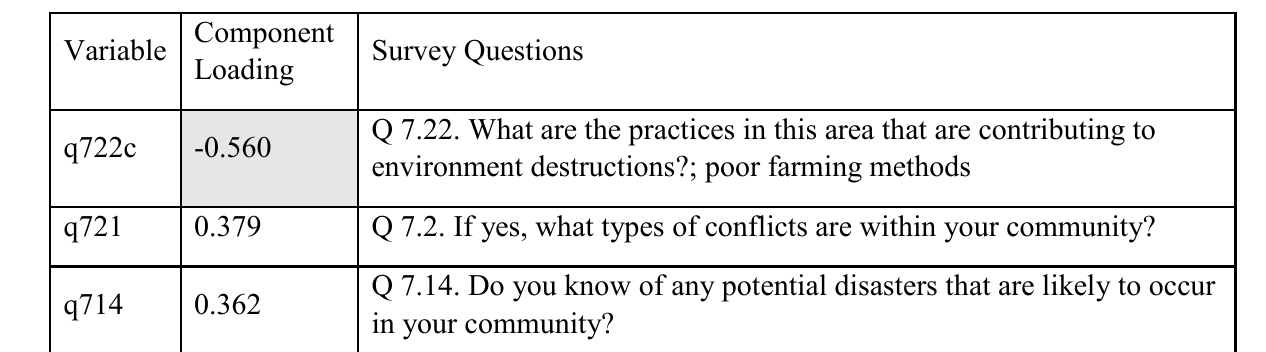
Table 1.34: Variables defining Adaptive Resilience